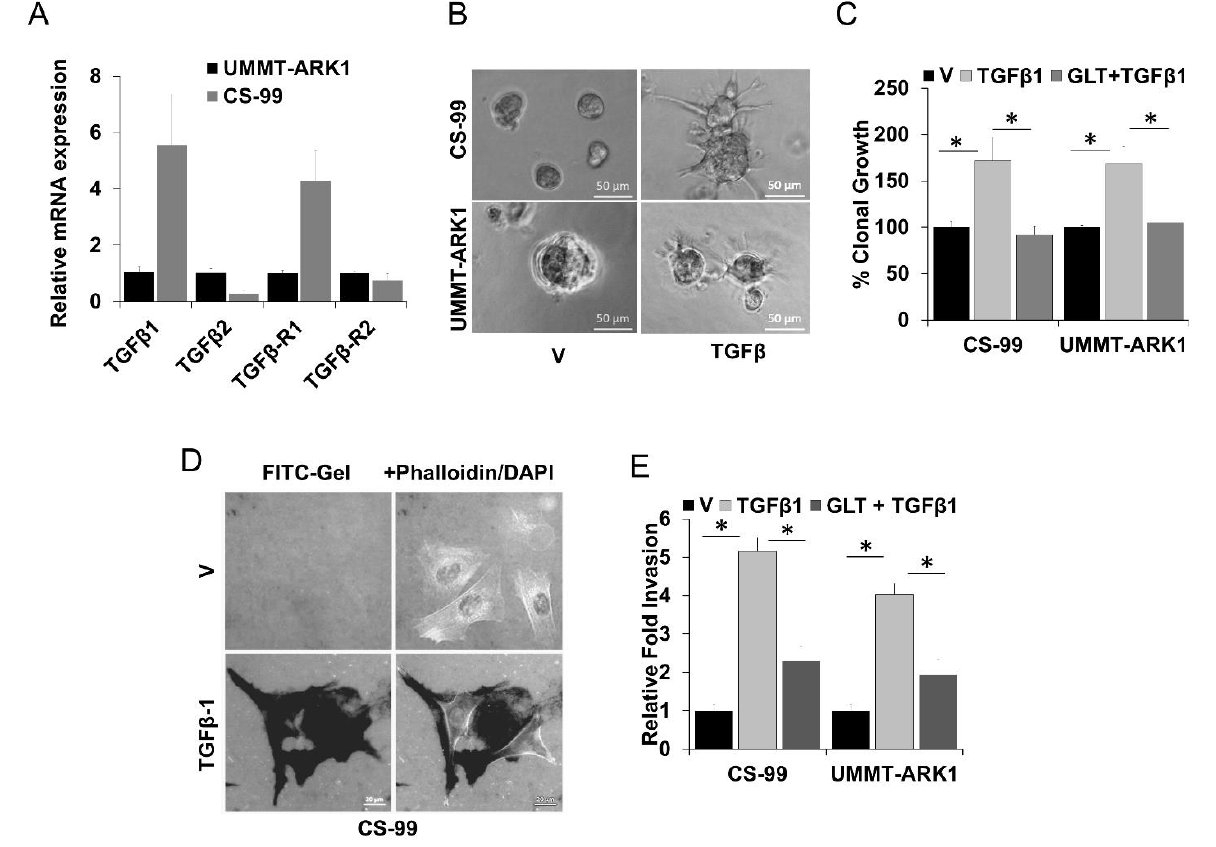
FIGURE 1: Role of TGFβ1 in mediating an aggressive UCS phenotype. (A) Relative mRNA expression of TGFβ1, TGFβ2, TGFβR1, and TGFβR2 in UMMT-ARK1 and CS-99 cells. Data are mean ± SE. (B) 1x10 4 UMMT-ARK1 and CS-99 cells were grown in 3D culture, once the colonies were visible they were treated as indicated for 48 h and imaged. Representative images are shown. (C) 1x10 4 UMMT-ARK1 and CS-99 cells were plated in Matrigel, treated with either control vehicle (V), TGFβ1 (5 ng/ml), or GLT (5 µM) + TGFβ1. Colonies were imaged and quantitated using Optronix Gelcount colony counter, % clonal growth compared to vehicle treated control are shown. (D) Representative images of CS-99 cells plated on Oregon Green 488 Gelatin – coated coverslips and treated with 5 ng/ml TGFβ1 for 18 h. The cells were fixed and the cellular F- Actin was stained with Alexa Fluor 555 Phalloidin and mounted in VECTASHIELD mounting medium containing DAPI, the dark areas in the left panels represent FITC-gelatin degradation. (E) Relative fold invasion derived from evaluation of <100 cells as shown in (D). Error bars repre- sent standard deviation. *, P<0.05 was considered